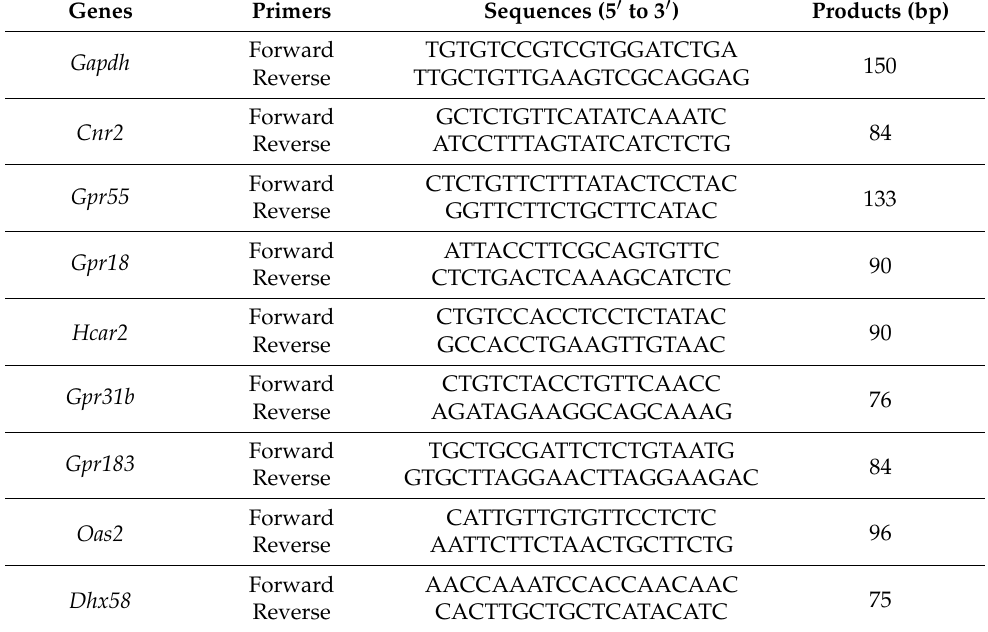
Table 1. Primers for qPCR